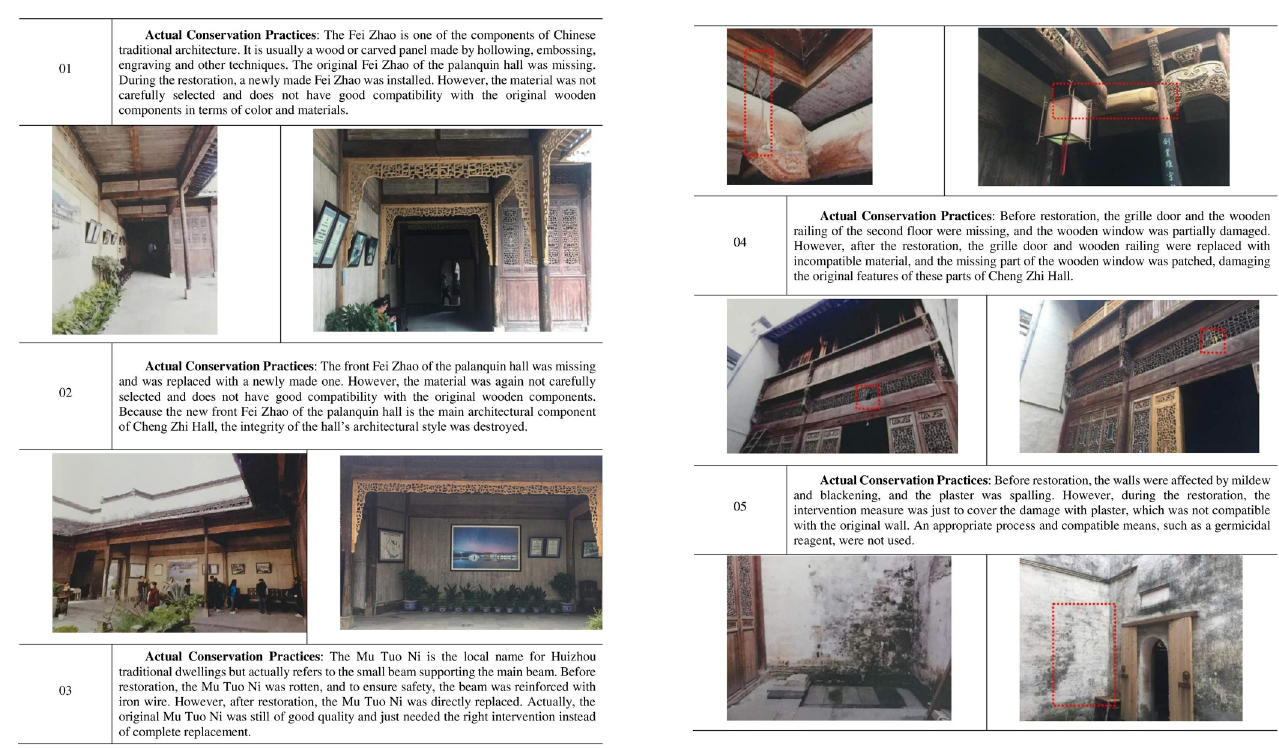
Fig 6. Examples of the actual conservation practices applied to Cheng Zhi